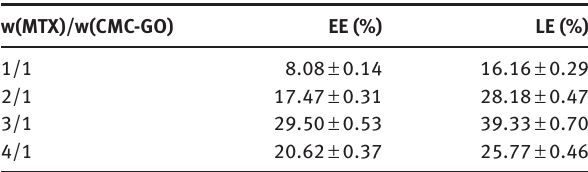
Table 1: Drug-loading efficiency and encapsulation